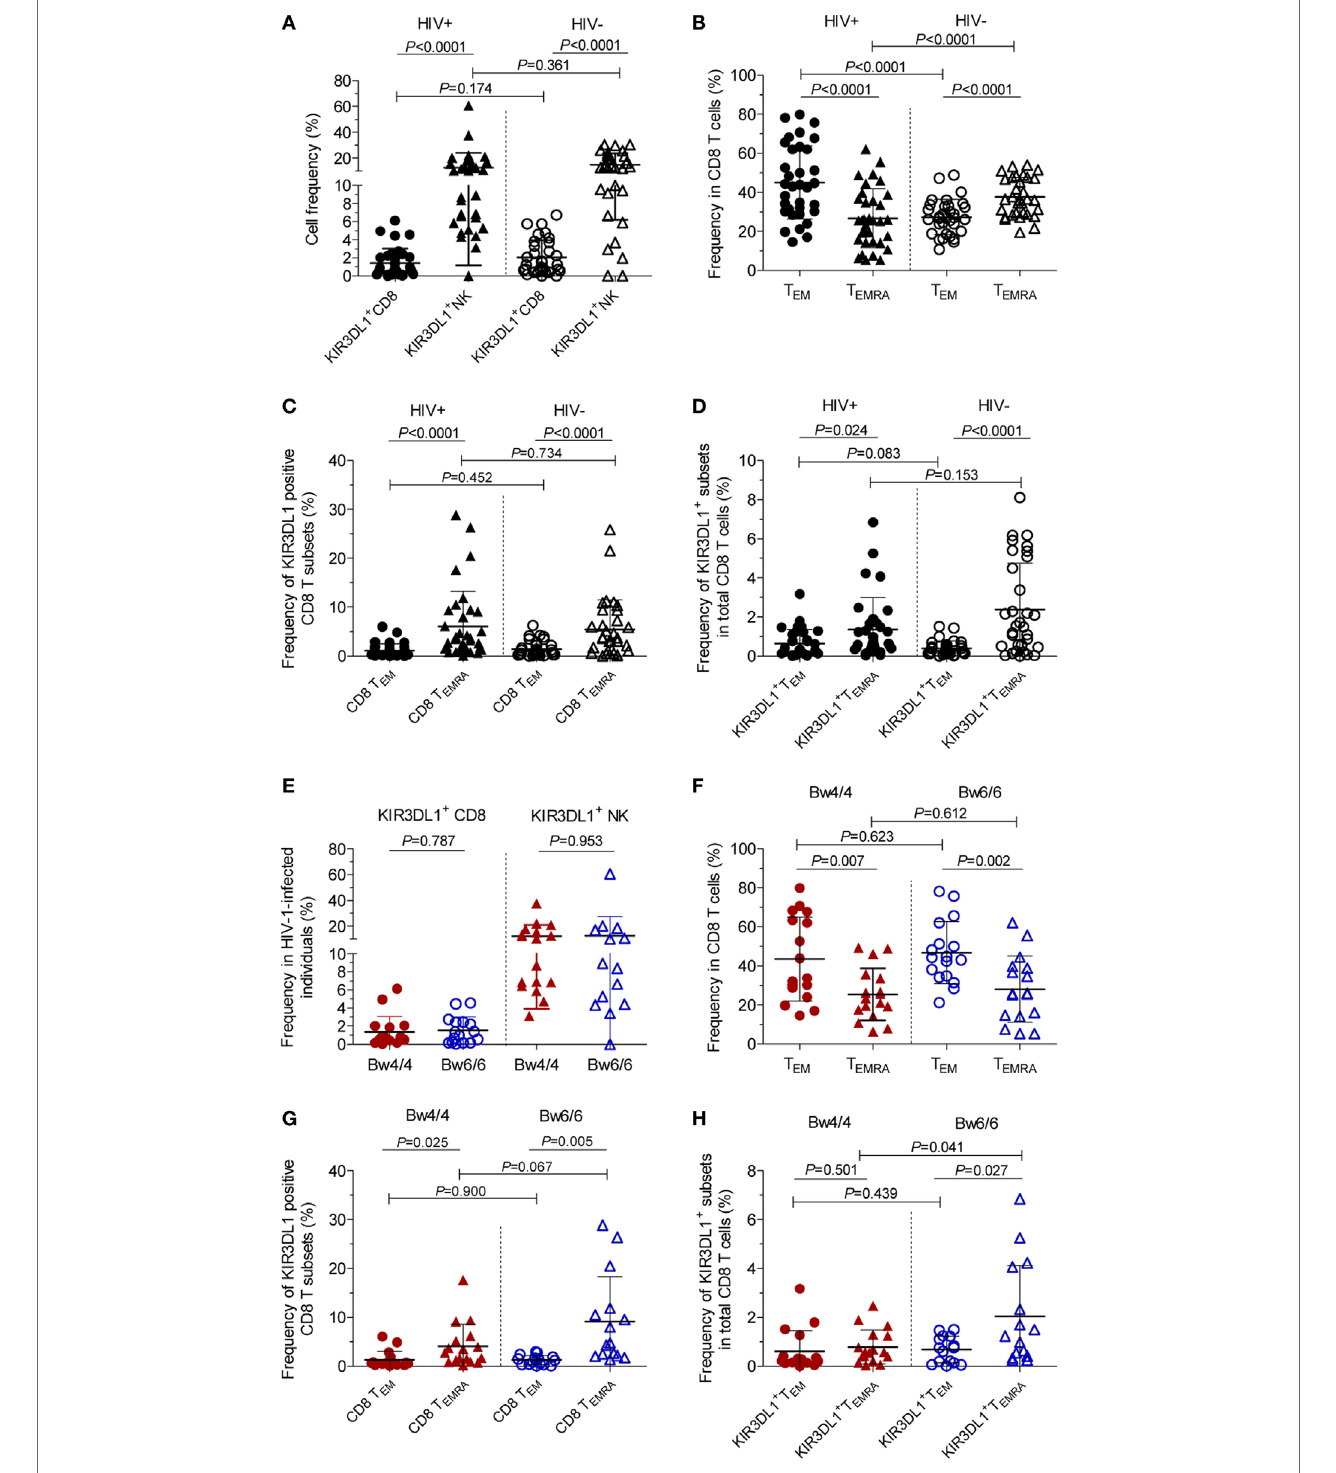
FigUre 2 | KIR3DL1 expression on natural killer (NK) cells, total CD8 T cells, and CD8 T-cell subsets. Differences in KIR3DL1 expression on total CD8 T cells or NK cells (a) , CD8 T EM (CD45RA − CCR7 − ) and CD8 T EMRA (CD45RA + CCR7 − ) subsets from total CD8 T cells (B,c) , and KIR3DL1 + T EM and KIR3DL1 + T EMRA from total CD8 T cells between human immunodeficiency virus type 1 (HIV-1)-positive patients at the acute/early stage and HIV-1-negative individuals (D) . KIR3DL1 expression on CD8 T cells or NK cells (e) , CD8 T EM and CD8 T EMRA subsets (F,g) , and KIR3DL1 + T EM and KIR3DL1 + T EMRA from total CD8 T cells (h) in HIV-1-infected patients homozygous for Bw4 or Bw6 . Data are expressed as mean ± SD. The significance of differences was analyzed in unpaired t -tests, with P < 0.05 considered significant. Bw4/4: Bw4 homozygotes (red); Bw6/6: Bw6 homozygotes